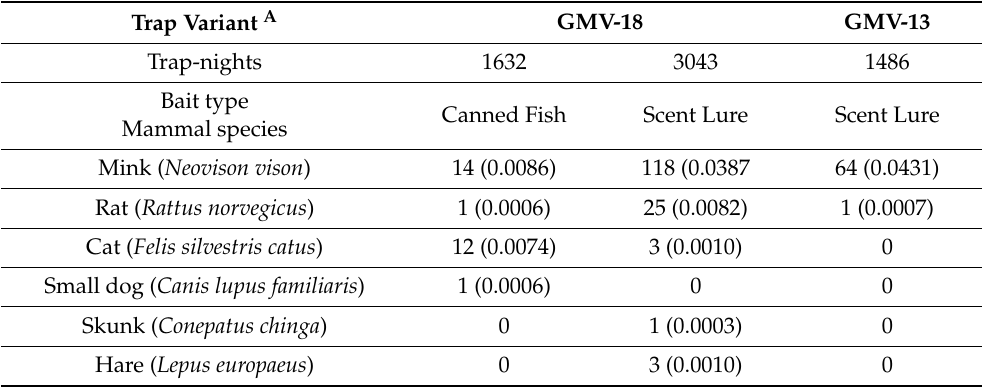
Table 4. Number of individuals per species trapped over 6161 trap-nights (and catch rate per trap-nights) according to bait type and trap variant.